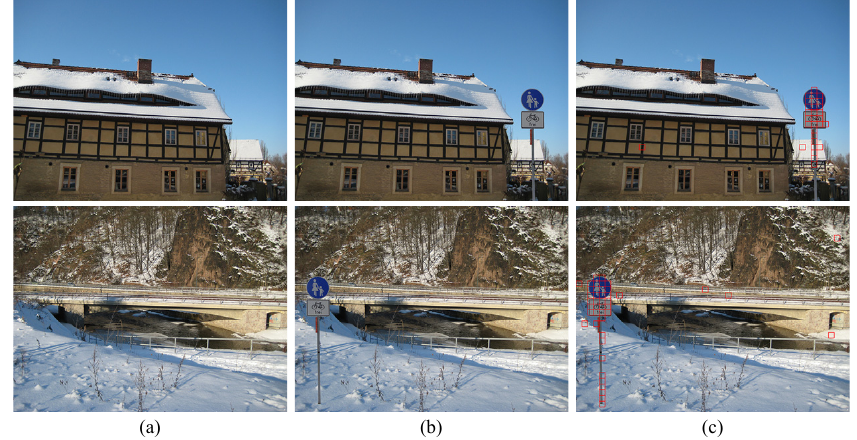
Figure 10. Image tampering detection. ( a ) Original images. ( b ) Tampered images. ( c ) Detection